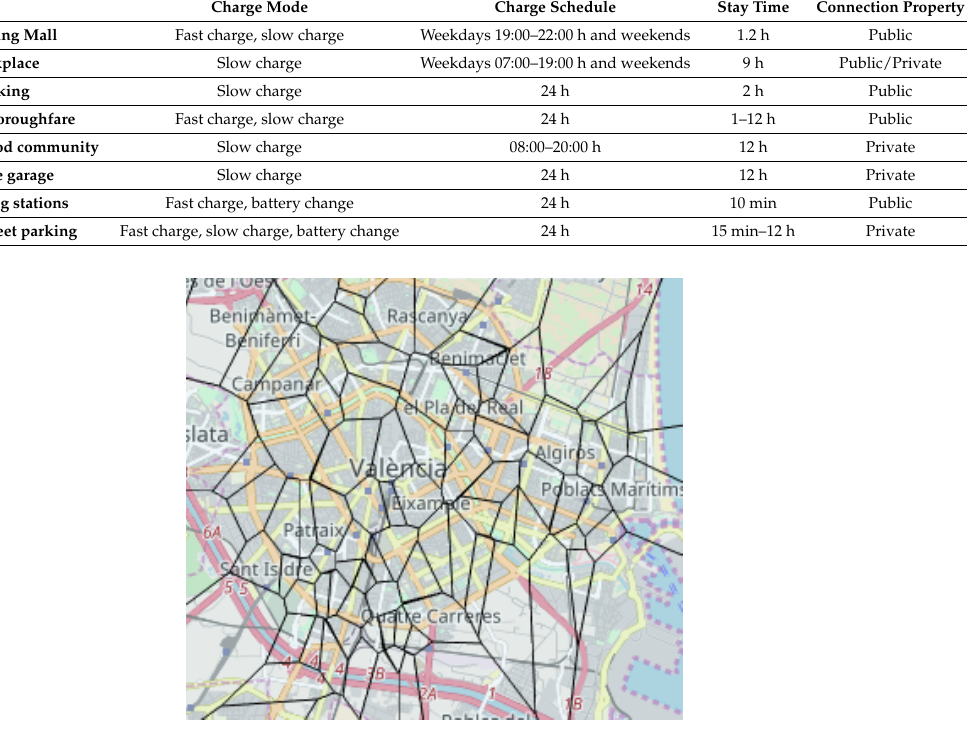
Figure 3. Voronoi diagram from the selected zones as potential points to locate charging